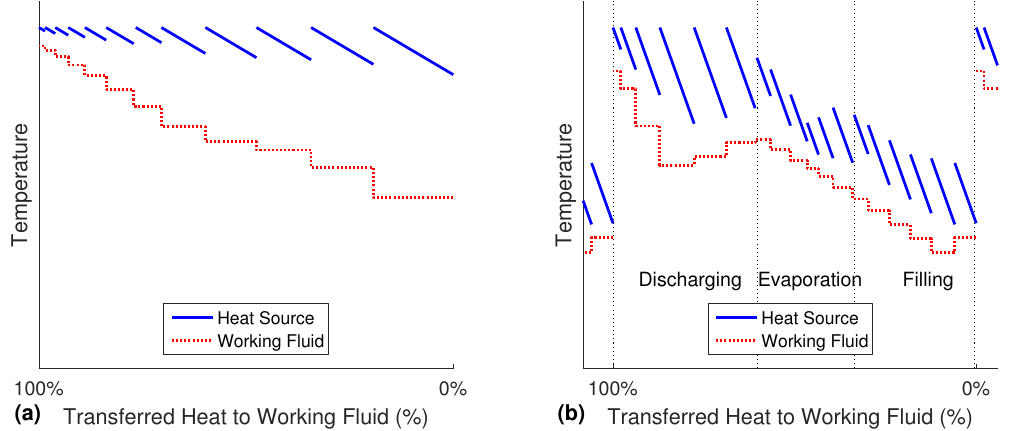
Figure 3. Qualitative piecewise T-Q-diagrams of the basic ideas of the Misselhorn cycle: ( a ) batch evaporation; ( b ) cascading heat source